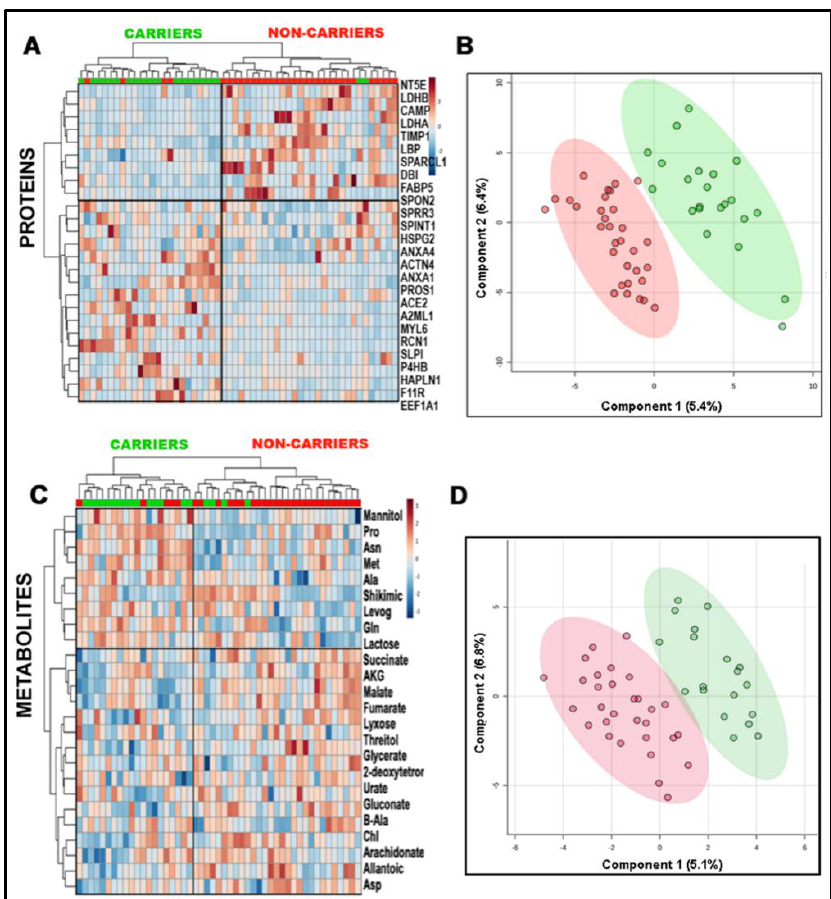
Figure 2. Classification of subjects by utilizing omics data, based on supervised and unsupervised learning models. An unsupervised agglomerative hierarchical clustering was performed using a Euclidean distance measure and Ward’s clustering algorithm; this analysis was visualized by showing the top 25 features in a heat map according to Student’s t test for proteins and metabolites between non-carriers and PM carriers ( A , C ). A supervised analysis (PLS-DA) was performed to identify the proteins and metabolites that separated the most carriers (green) from non-carriers (red) ( B , D ; see details in Supplementary Figure S4).